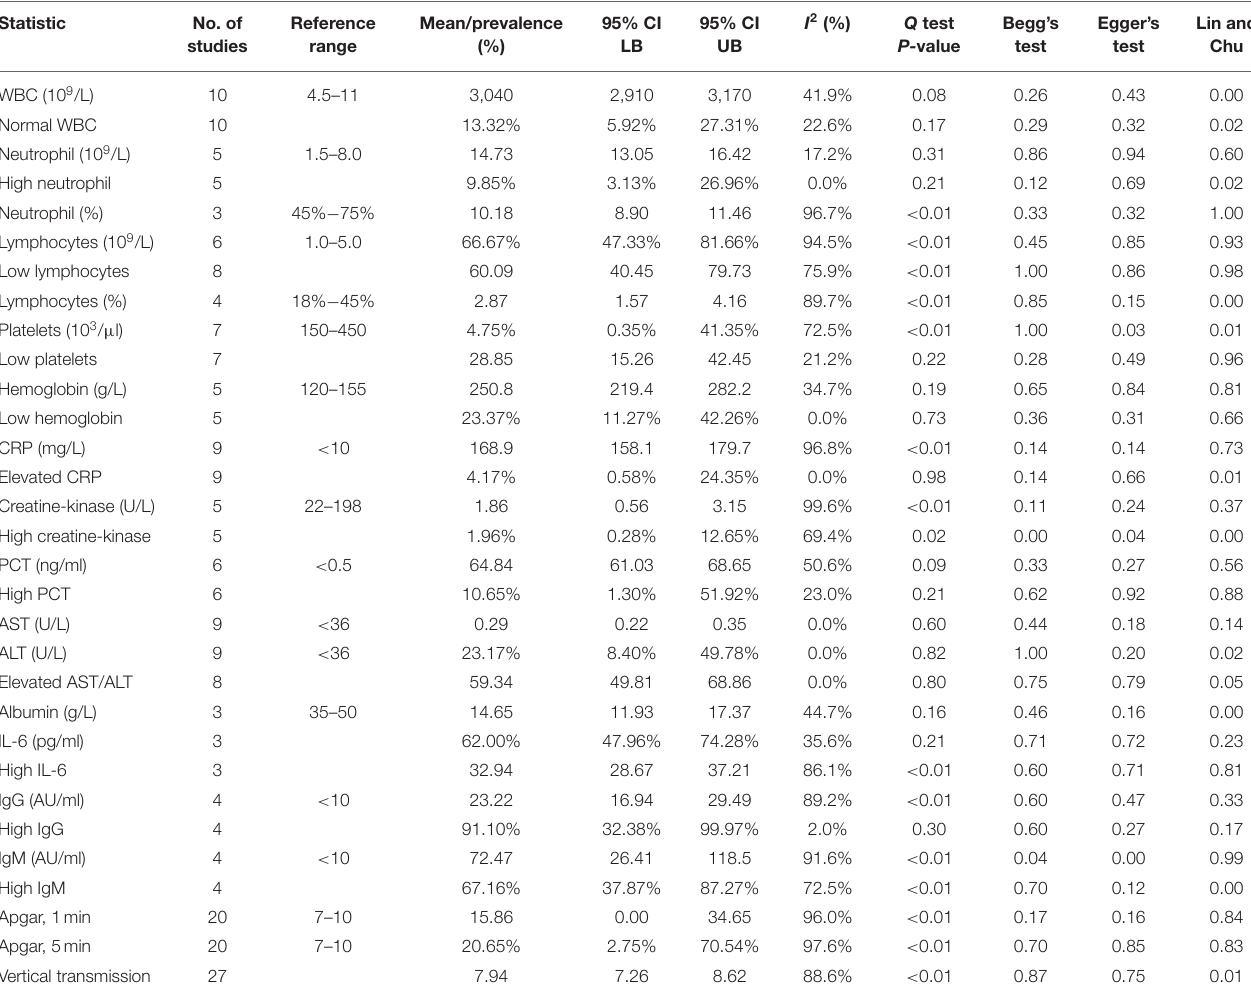
TABLE 5 | Meta-analysis of neonatal laboratory tests and